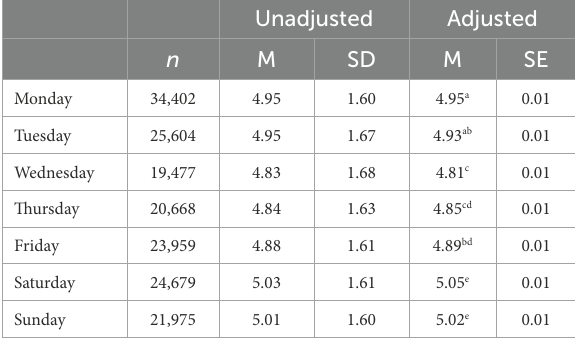
TABLE 1 Descriptive statistics of the liberalism-conservatism